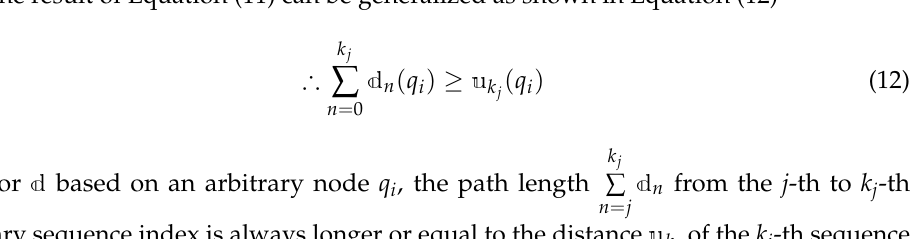
Comparing Figure 6c,e, according to Equation (7), the rewired distance u 2 ( q 0 ) is 2 d d ∑ ( q ) from d shorter than the path length n 0 0 to 2 and the rewired distance n = 0